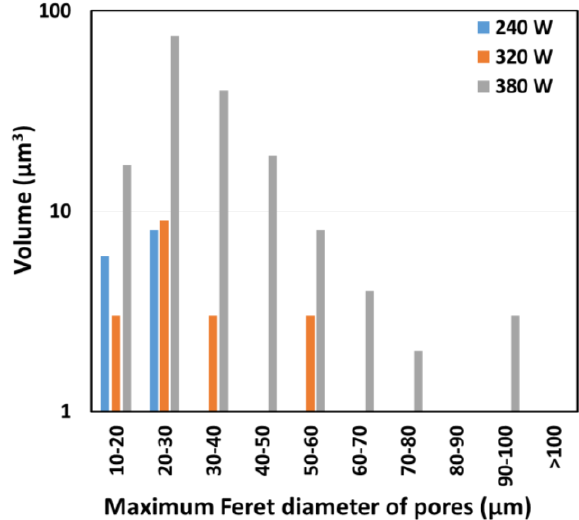
Figure 7. Plot of the pore volume versus their maximum Feret diameter determined from µCT analyzes of the samples produced at 240 W, 320 W, and 380 W.